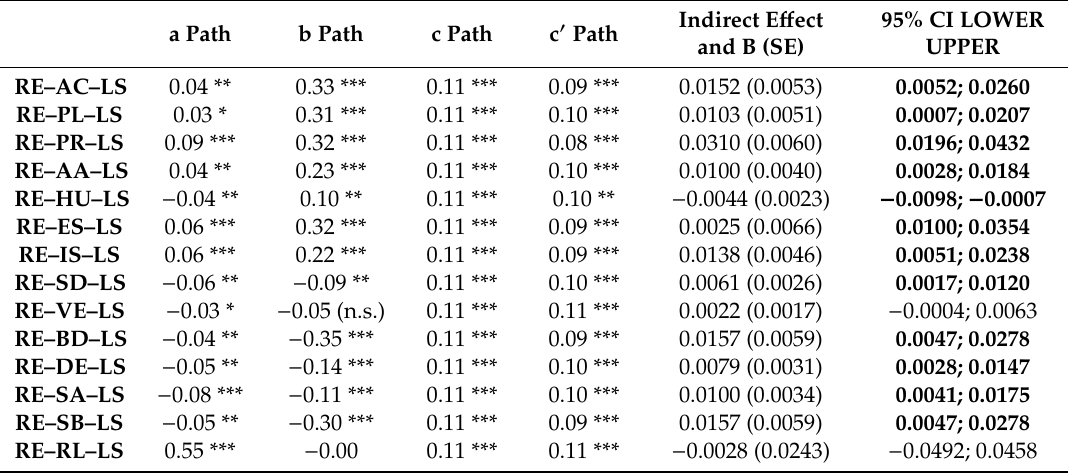
Table 3. The role of coping strategies on religious comfort and life satisfaction (N = 744).